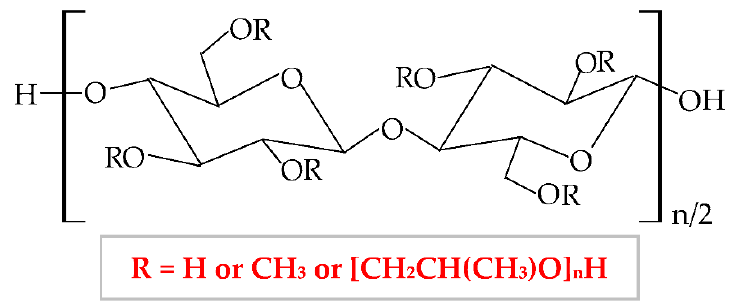
Figure 8. Chemical structure of hydroxypropylmethylcellulose (HPMC).